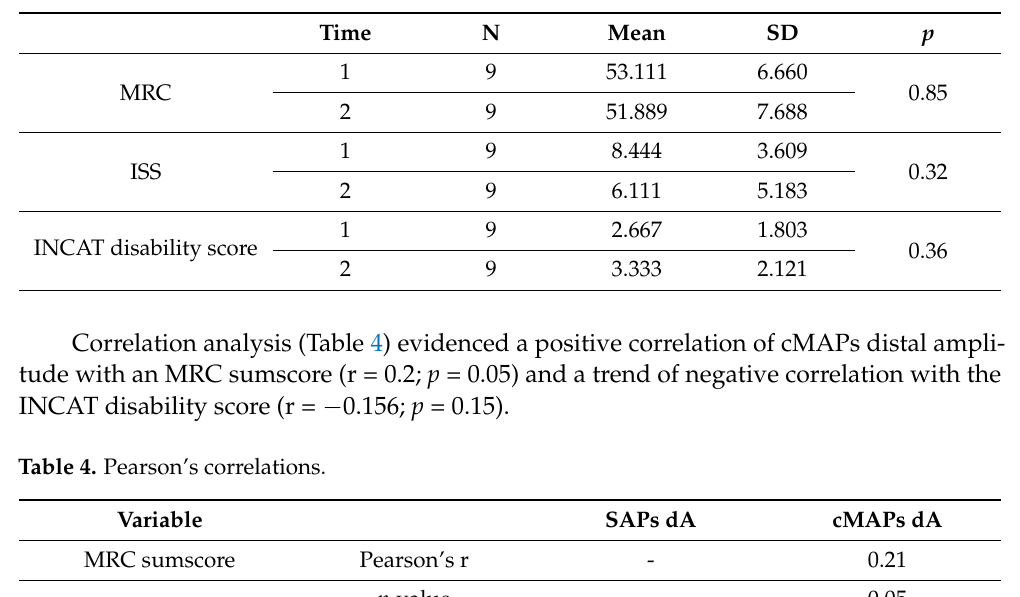
Table 3. Clinical scores. Time 1: pre-SCIg; time 2: during SCIg; MRC: Medical Research Council sumscore; ISS: INCAT sensory scale; SD: standard deviation.